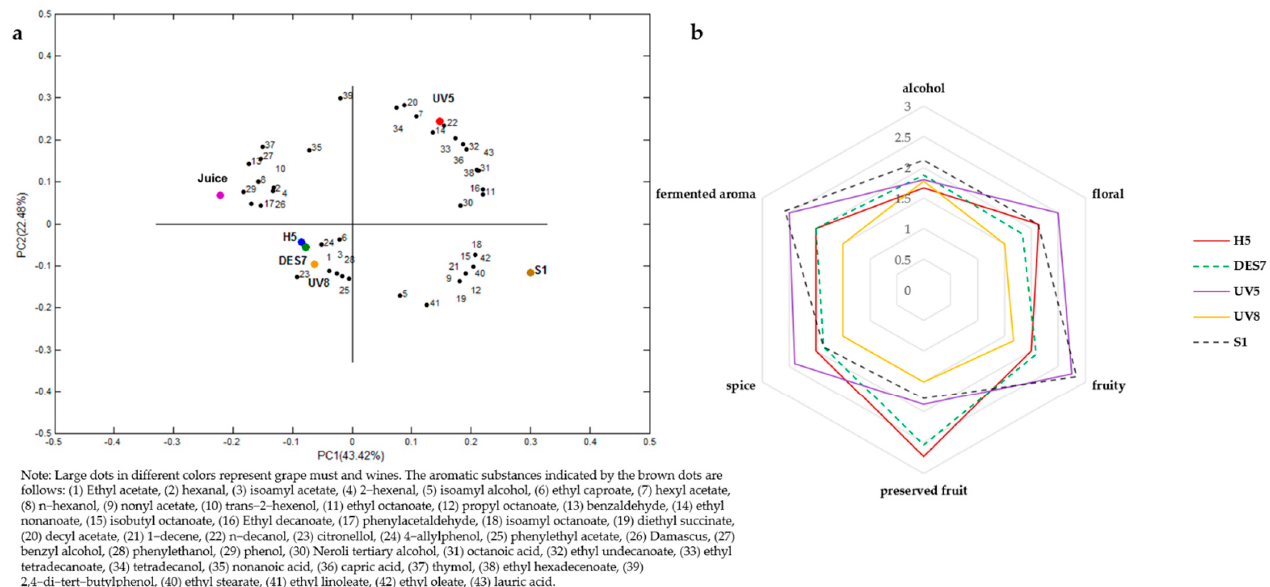
Figure 5. ( a ) PCA of selected volatile compounds in Cabernet Sauvignon must and wine; ( b ) the aroma radar map of the sensory evaluation.